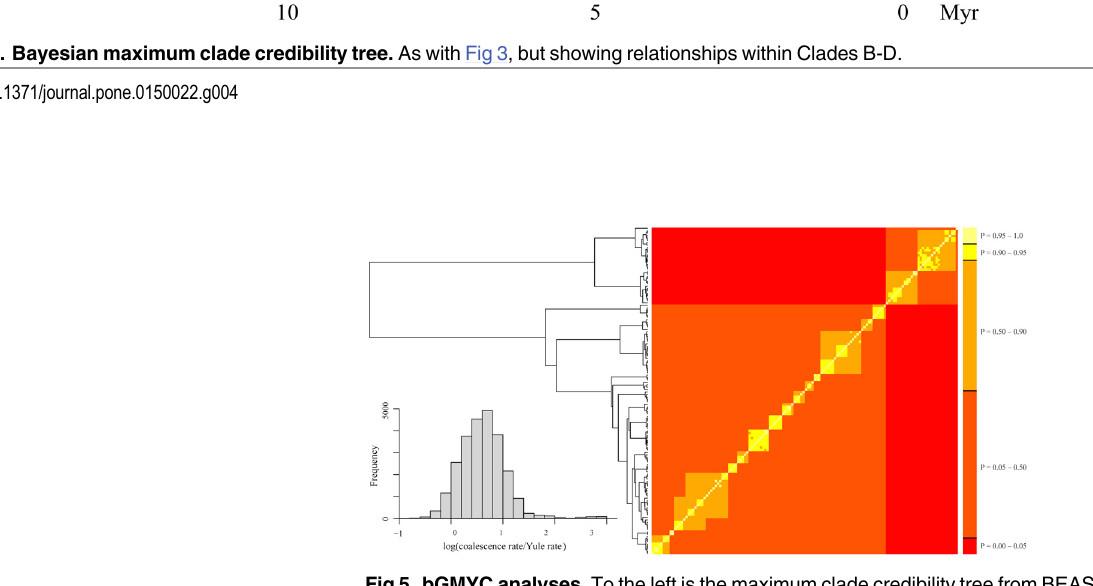
Fig 5. bGMYC analyses. To the left is the maximum clade credibility tree from BEAST 2 (Figs 3 and 4). The table is a sequence-by-sequence matrix, with cells colored by the posterior probability that the corresponding sequences are conspecific. Off-diagonal colors indicate uncertainty due to uncertainty in